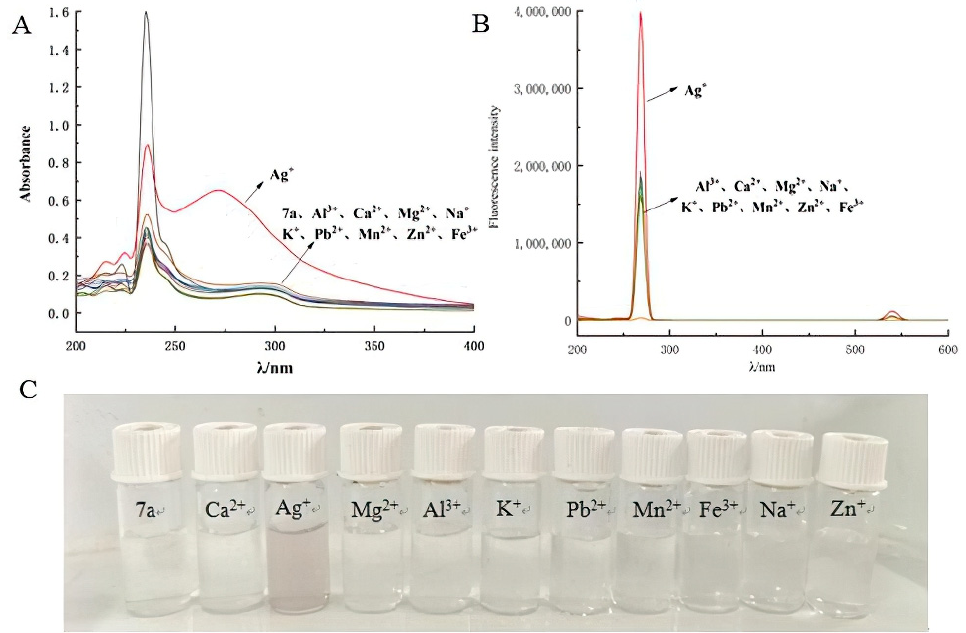
Figure 1. ( A ) UV-Vis absorption spectra of compound 7a (1.6 × 10 − 5 mol/L) with the addition of different metal ions (8.3 × 10 − 5 mol/L). ( B ) Fluorescence spectra of host compound 7a (1.6 × 10 − 5 mol/L) after adding different metal ions (8.3 × 10 − 5 mol/L). ( C ) Color change of host compound 7a (1.6 × 10 − 5 mol/L) with different metal ions (8.3 × 10 − 5 mol/L).